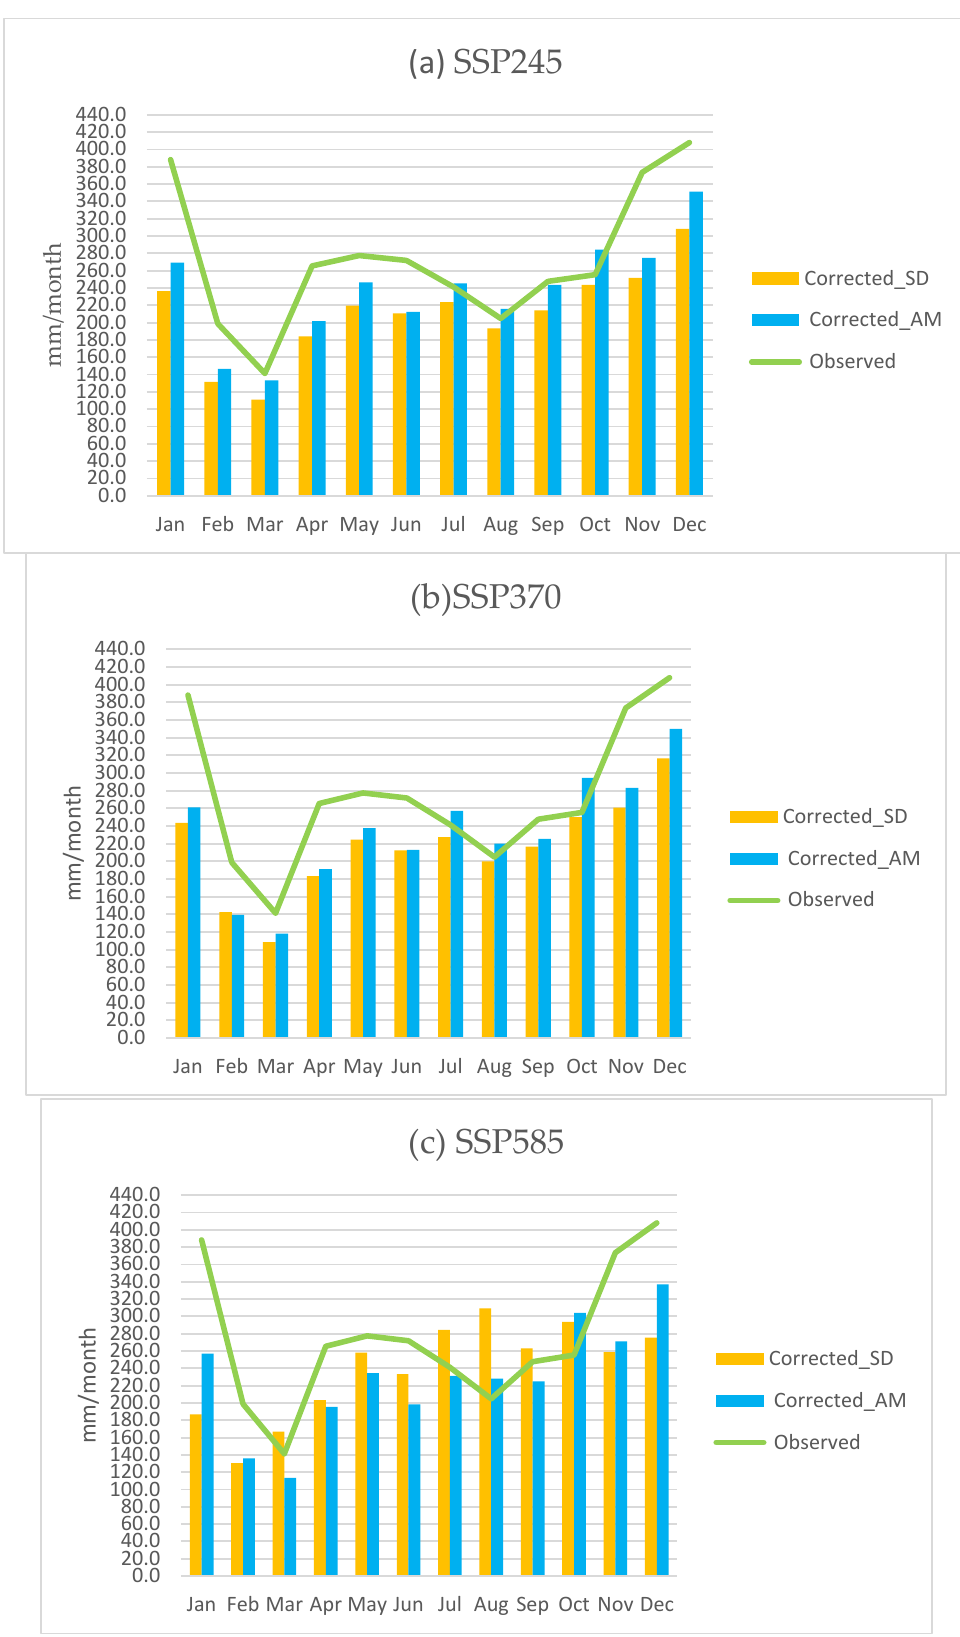
Figure 4. Validation Period (2015 – 2019) under for SD and AM approach under ( a ) SSP245; ( b ) the SSP370 and ( c ) SSP585.